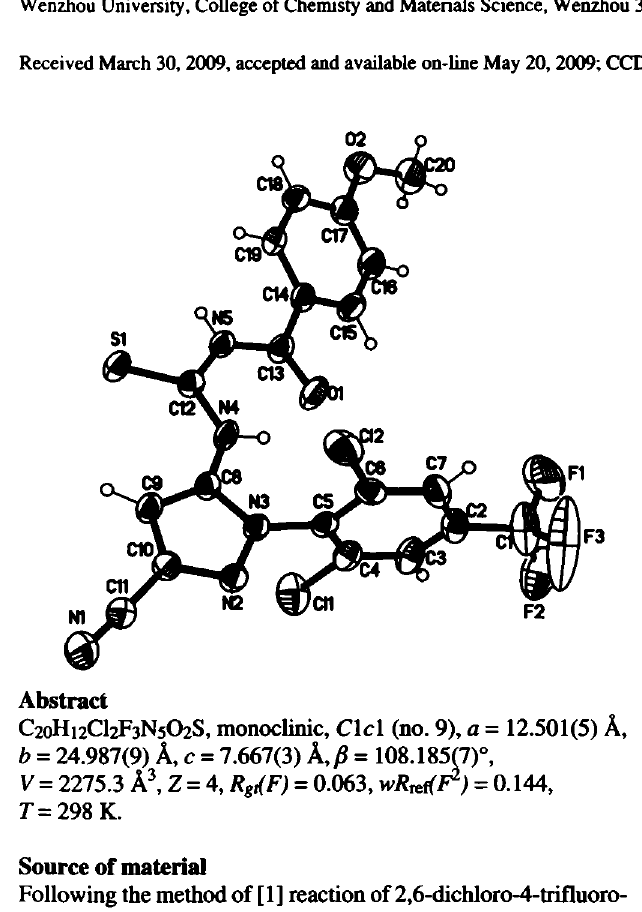
Table 1. Data collection and handling.